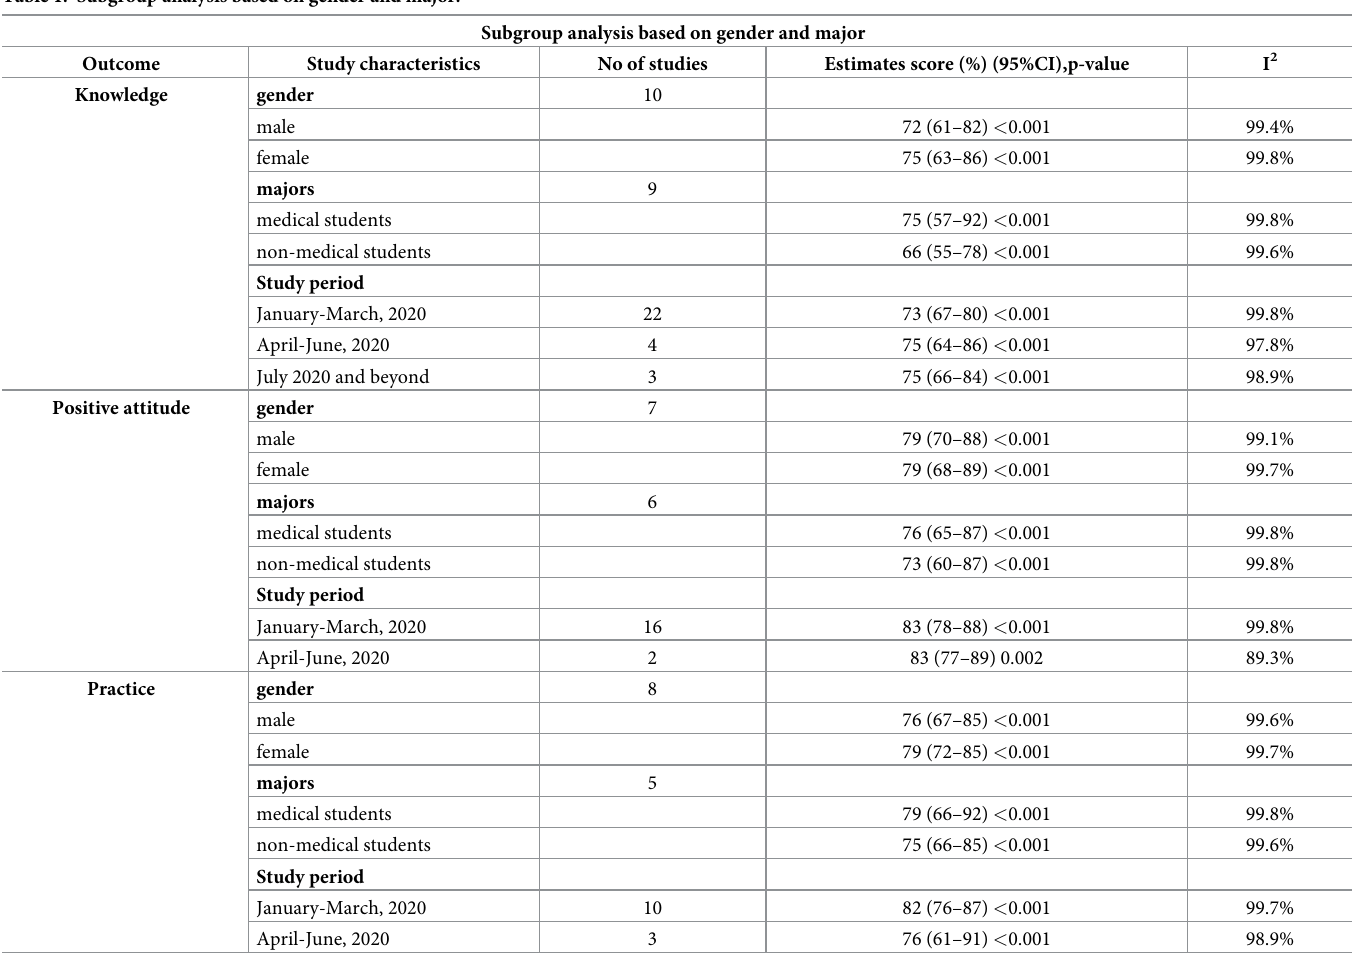
Table 1. Subgroup analysis based on gender and